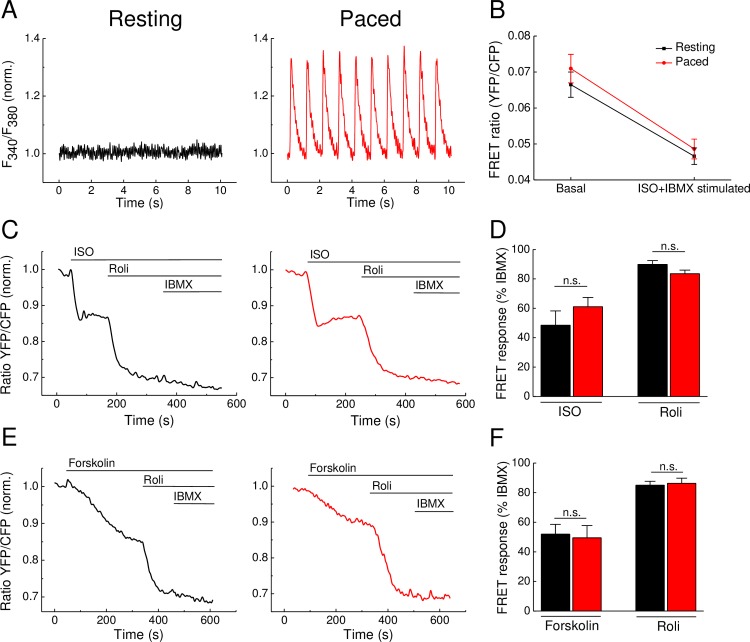
cAMP dynamics in adult mouse ventricular Epac1-camps expressing cardiomyocytes upon treatment with cAMP elevating agents and PDE4 inhibition.(A) Representative calcium traces in Fura2-AM loaded Epac1-camps transgenic cardiomyocytes under resting conditions (left) and upon electric field stimulation at 1 Hz (right). (B) Non-normalized FRET ratios do not differ between resting and paced Epac1-camps cardiomyocytes under basal and stimulated conditions (isoproterenol—ISO, 100 nM—plus 3-isobutyl-1-methylxathin—IBMX, 100 μM). (C) Representative FRET traces from Epac1-camps cardiomyocytes stimulated with the β-AR agonist isoproterenol (ISO, 100 nM) or (E) with the direct AC activator forskolin (10 μM) leading to an increase of cAMP visualized as a decrease in the FRET ratio. Inhibition of PDE4 by rolipram (Roli, 10 μM) strongly enhances this effect, whereas the unselective PDE inhibitor IBMX (100 μM) has only little additional effect. (D and F) Quantification of the FRET results reveal no significant differences in FRET ratio changes between resting and paced cardiomyocytes. Cells were paced at 1 Hz. Values are means ± SEM; from n = 6 cells isolated from 3 hearts per condition; n.s.—not significant by one-way ANOVA.